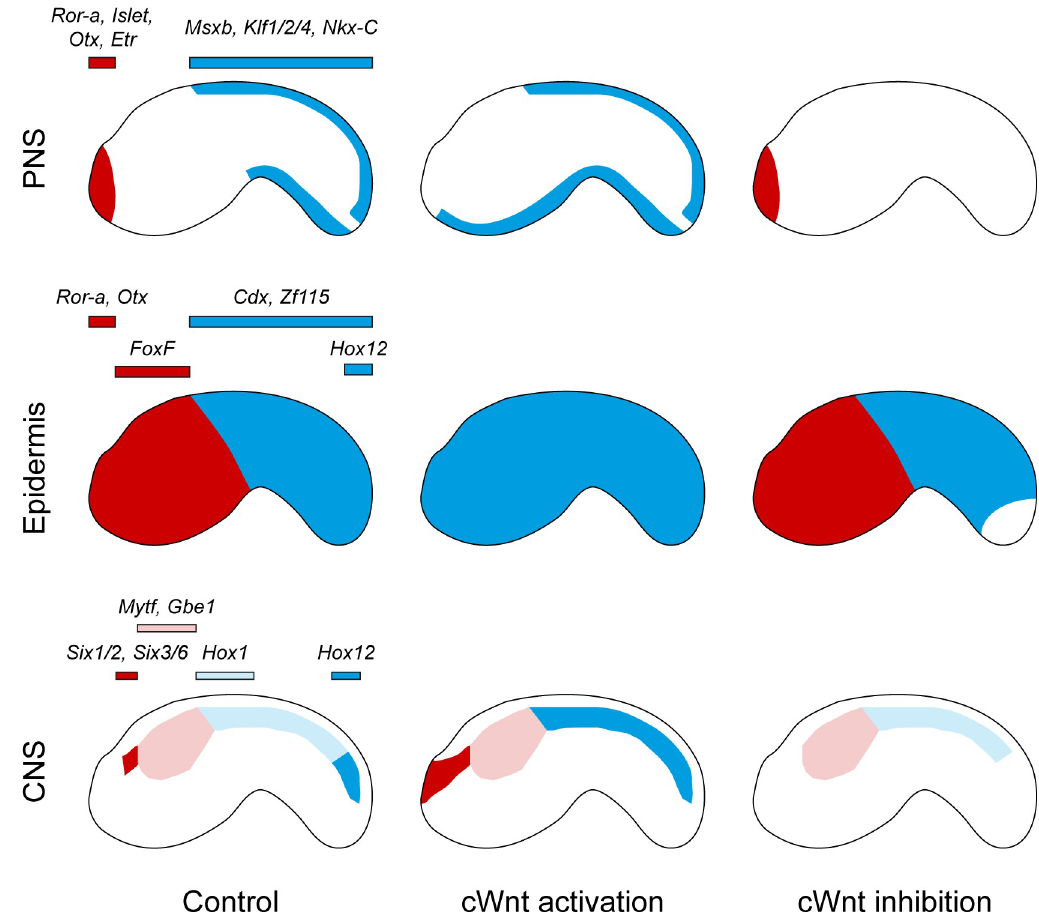
Fig 8. Summary of phenotypic effects of cWnt modulation on ectoderm AP patterning in Ciona intestinalis . Schematic representation of the results obtained in this study for the AP pattern of the PNS, the epidermis and the CNS following cWnt activation or inhibition. Red: anterior. Blue: posterior. Some of the key patterning genes whose expression has been determined in functional studies are listed above each domain.